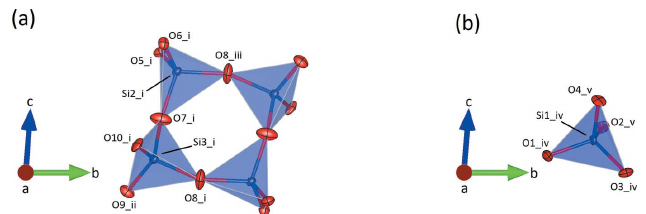
Figure 1 ( a ) [Si 4 O 12 ] vierer single ring and ( b ) insular [SiO 4 ] tetrahedron in the crystal structure of (K 1.5 Na 0.5 )Ca 3 Si 3 O 10 . The projection is parallel to [100]. Oxygen and silicon atoms are shown in red and blue, respectively. Displacement ellipsoids are drawn at the 70% probability level. [Symmetry codes: (i) x , y (cid:3) 1, z ; (ii) 1 (cid:3) x , (cid:3) y , (cid:3) z ; (iii) 1 (cid:3) x , 1 (cid:3) y , (cid:3) z ; (iv) 1 + x , y , z ; (v) 2 (cid:3) x , 1 (cid:3) y , 1 (cid:3) z ]